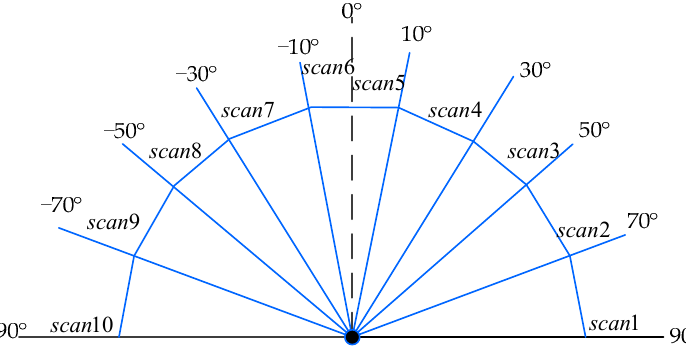
Figure 4. The detection range of laser sensor on mobile robot.